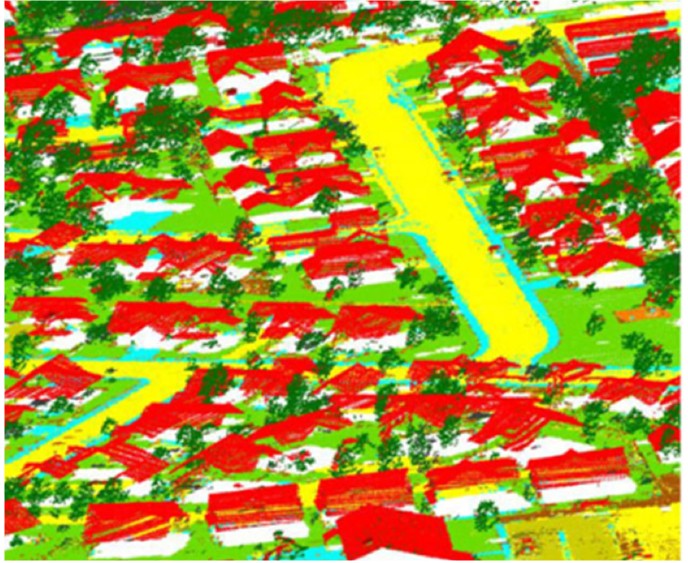
Figure 4. An example of a 3D point cloud classified into six classes (buildings, soil, grass, trees, asphalt, and concrete) by Ekhtari et al. [119].